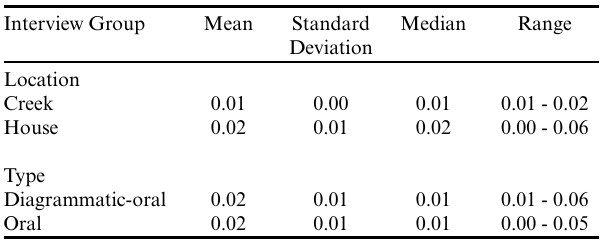
Table 3 . Mean and median density value of mental models elicited using the different interview